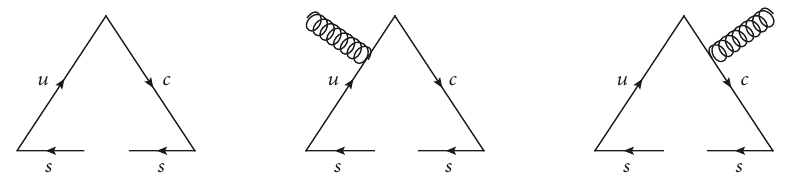
Figure 2: Nonperturbative diagrams for the off-shell 𝐷 ∗